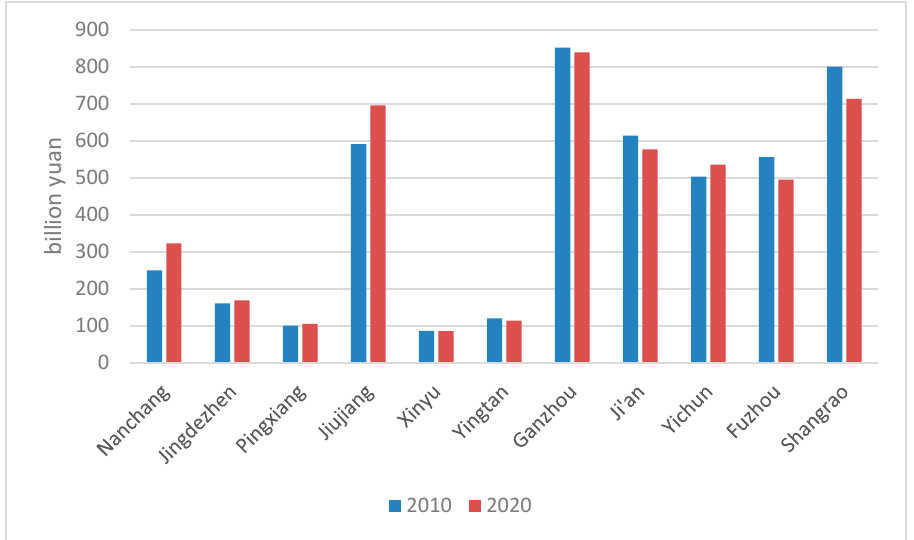
Figure 3. Gross Ecosystem Product of Cities in Jiangxi Province (2010–2020).